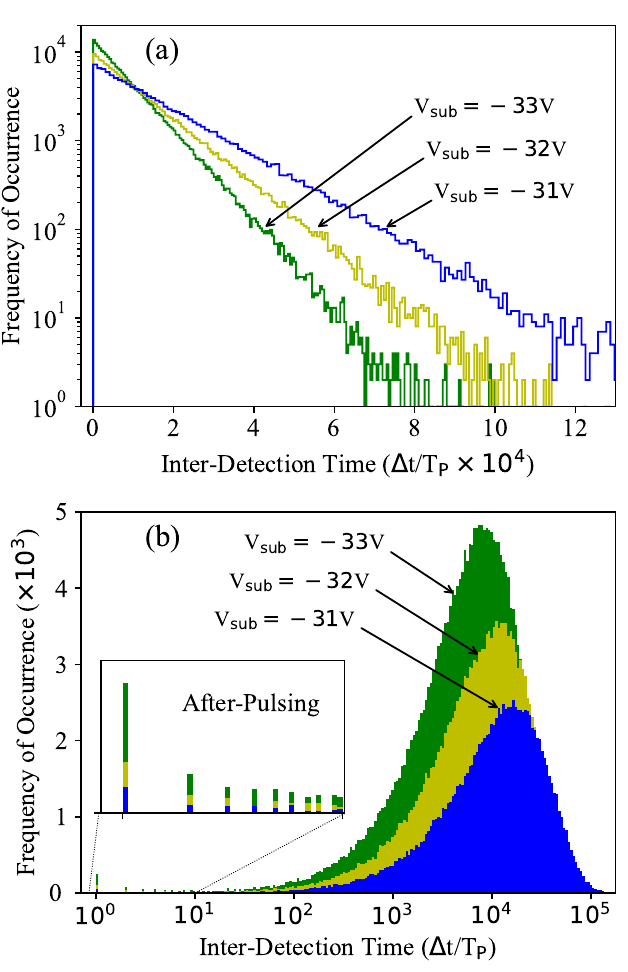
Figure 3. Distribution of the interdetection times at three different biasing conditions and g = 0.2 with ( a ) uniform and ( b ) exponentially increasing bin